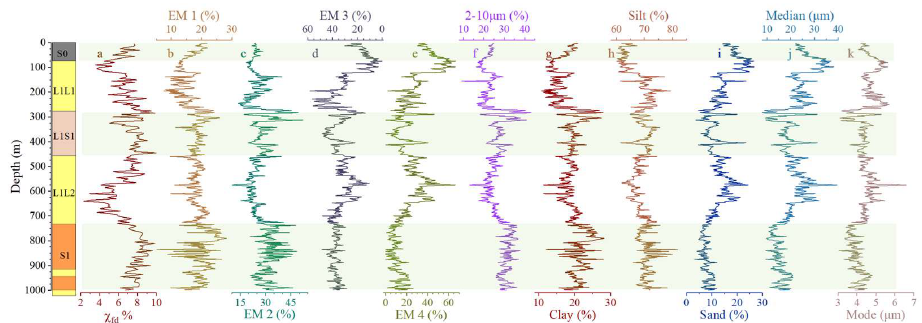
Figure 3. Variation in ( a ) χ fd %, ( b ) clay, ( c ) silt, ( d ) sand, ( e ) the content of the 2–10 μm component, ( f ) EM1, ( g ) EM2, ( h ) EM3, and ( i ) EM4, with ( j ) median grain size and ( k ) mode grain size along